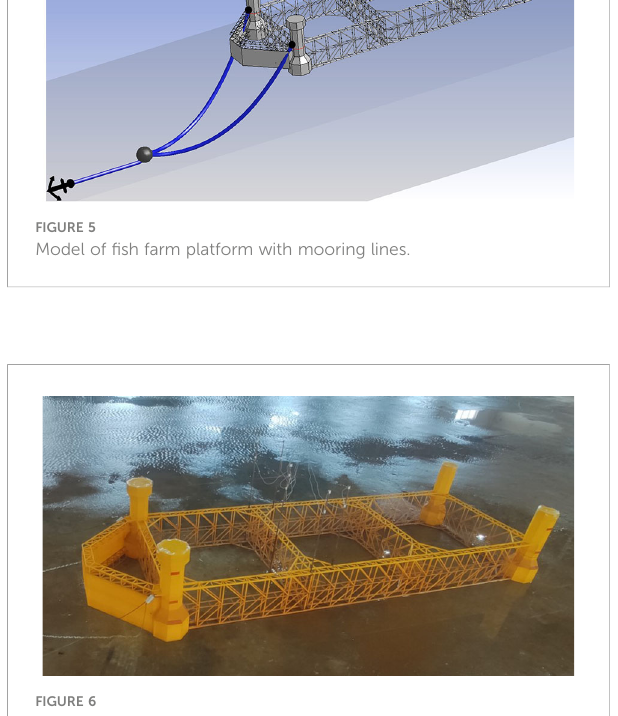
FIGURE 6 Physical model of fi sh farm